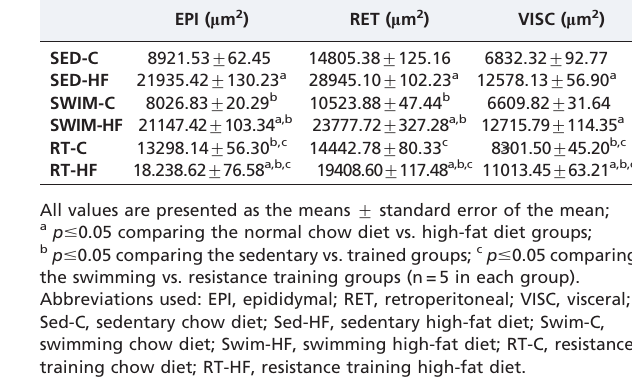
swimming chow diet; Swim-HF, swimming high-fat diet; RT-C, resistance training chow diet; RT-HF resistance training high-fat diet.